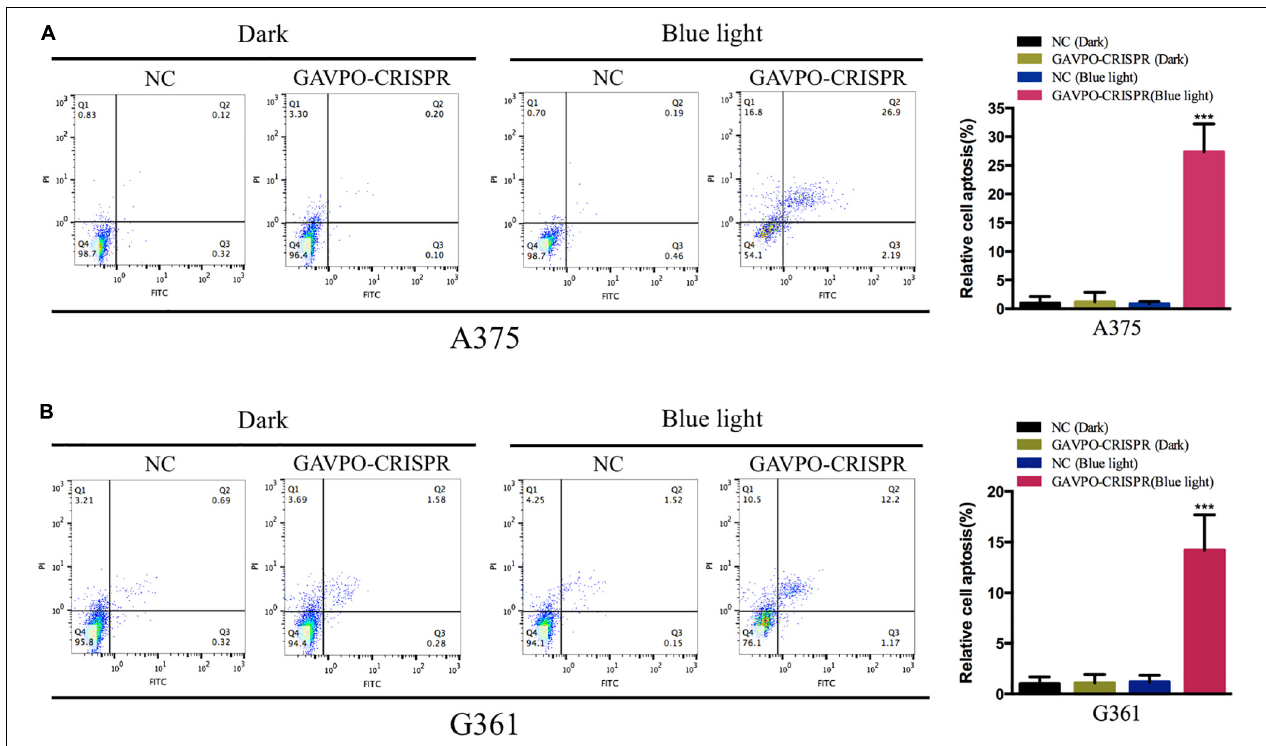
FIGURE 6 | Light-induced GAVPO-CRISPR system promoted melanoma cell apoptosis. (A) Flow cytometry results representing the effect of light-induced GAVPO-CRISPR system under blue-light or dark conditions on cell apoptosis in A375 cells, compared to the negative control. (B) Flow cytometry results representing the effect of light-induced GAVPO-CRISPR system under blue-light or dark conditions on cell apoptosis in G361 cells, compared to the negative control. Data are presented as the means ± SD from at least three biological replicates. (* P < 0.05, ** P < 0.01, *** P <